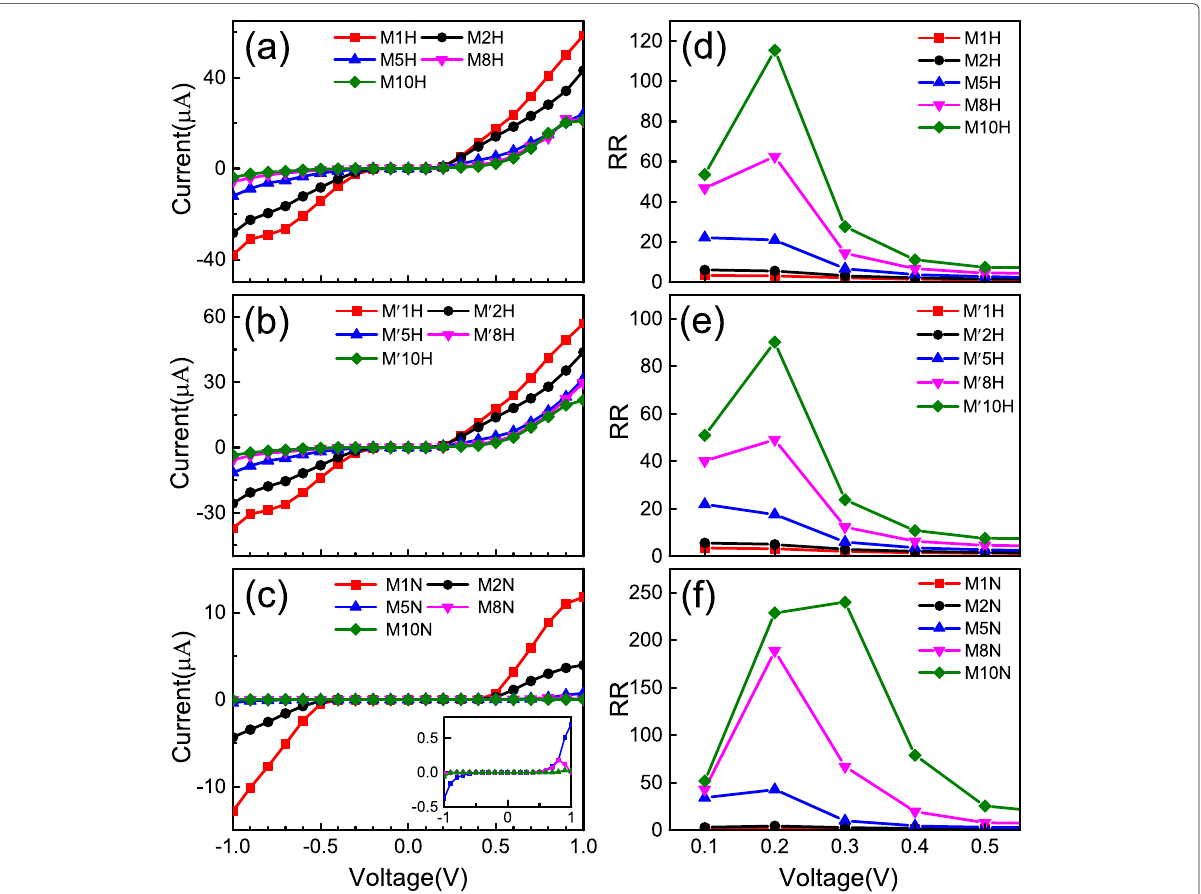
Fig. 3 The I - V characteristics and rectification ratios for the three types of heterojunctions, where a – c correspond to I - V curves for junctions M n H, M (cid:2) n H, and M n N ( n = 1, 2, 5, 8, 10) within bias range of ( − 1,1) V, respectively. The inset in c is the enlarged I - V curves of M n N within the bias range. d – f The rectification ratios calculated correspondingly from the I-V